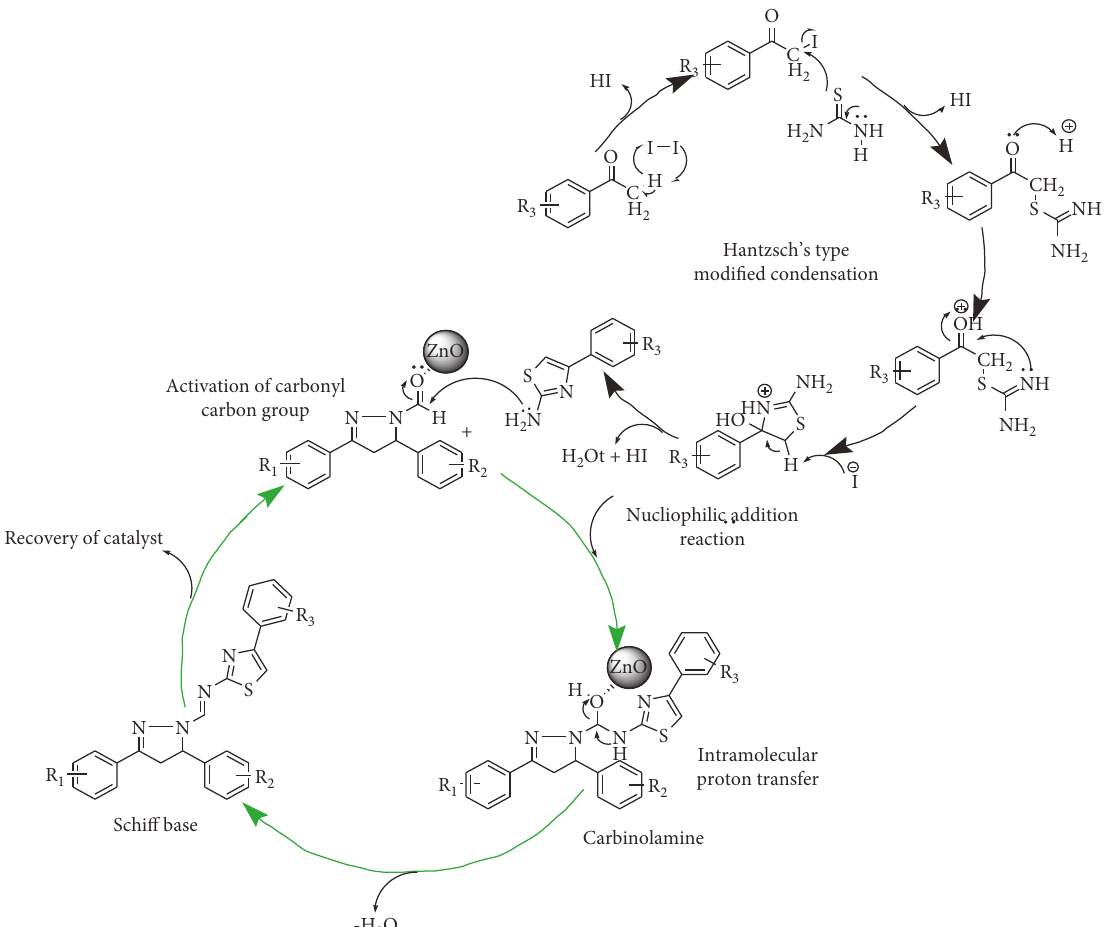
Scheme 5: A plausible mechanism for the synthesis of thiazolyl-pyrazoline Schiff base hybrids via ZnO nanoparticles as a